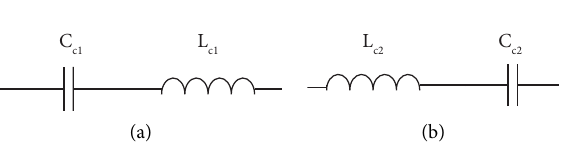
Figure 11: Rectifying circuit topology.